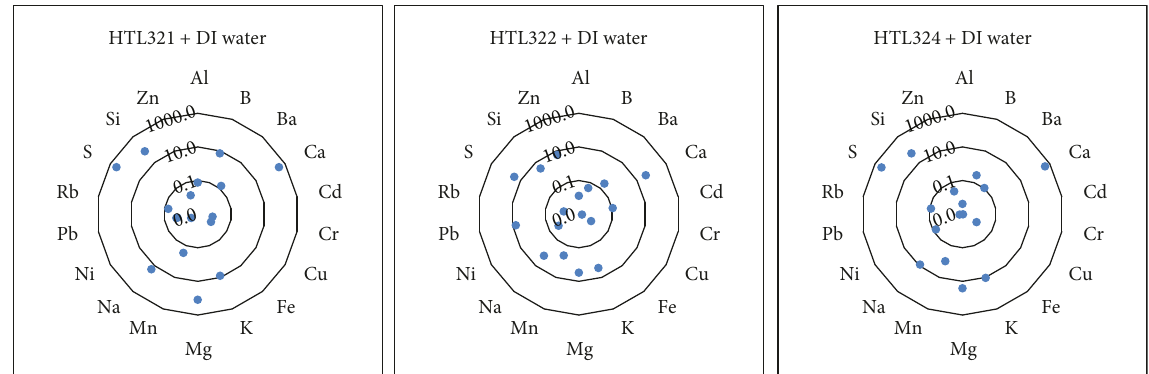
Figure 13: Elemental composition (in ppm) of each leachate from samples reacted with deionised water at 200 ° C temperature under 250 bar pressure in the fl ow-through reactor after 52 minutes, 48 minutes, and 25 minutes, respectively (absence of data points re fl ects concentrations below the limits of detection).